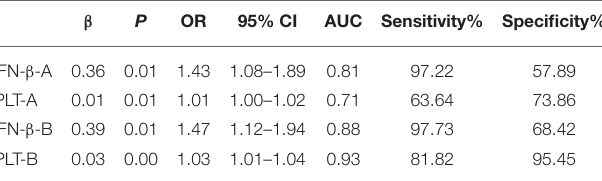
TABLE 6 | Logistic regression analysis and AUC of IFN- β and PLT for acute and subacute phase of Kawasaki disease.